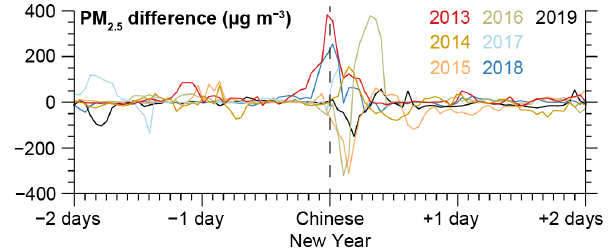
Figure 11. Differences between mean PM 2 . 5 concentrations inside and outside the 5th Ring Road of Beijing from 2013 through 2019. Positive values indicate higher concentration inside 5th Ring